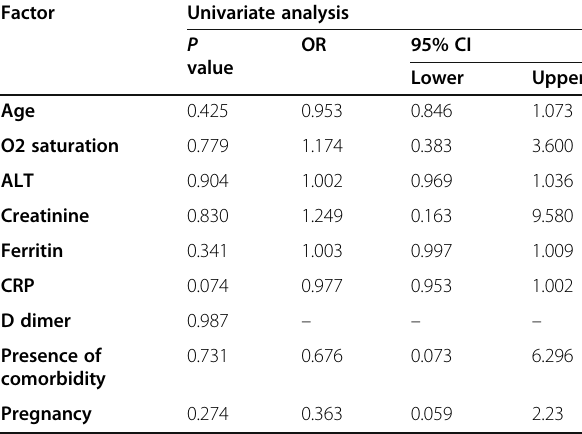
Table 4 Univariate analysis of possible risk factors associated with patients ’ mortality in the studied groups, Egypt, 2020